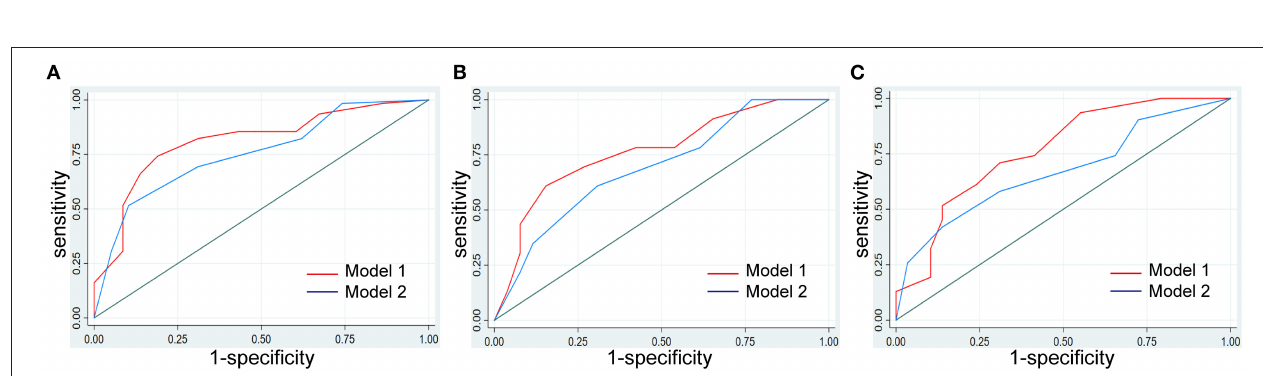
Frontiers in Medicine |